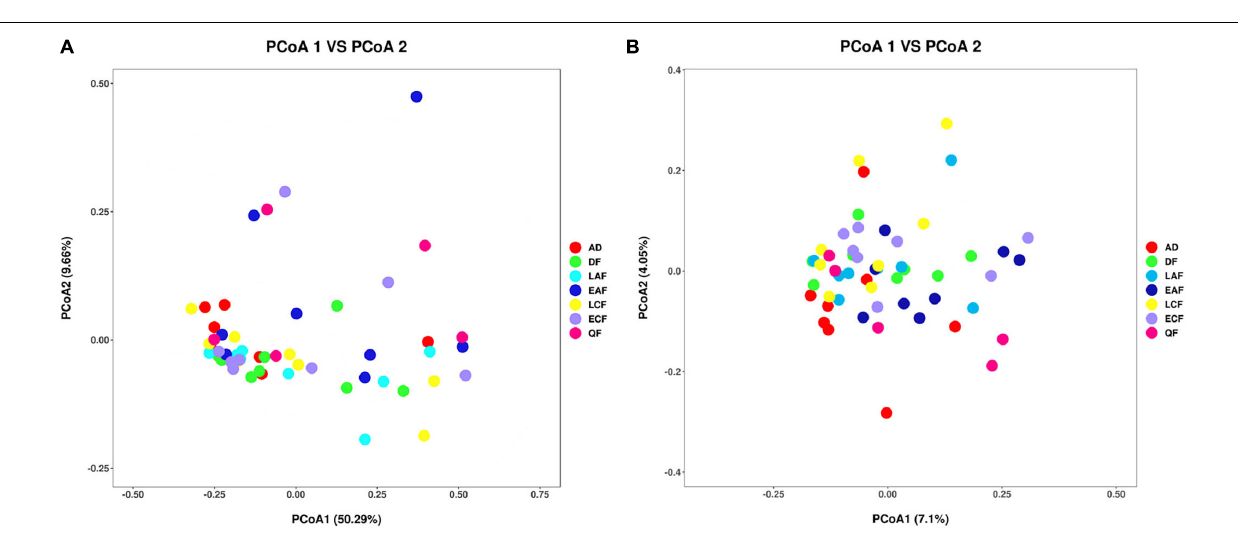
FIGURE 3 | Differential gut microbiota communities across all samples. (A) Principal coordinate analysis plot of weighted UniFrac distances for the F. tinnunculus species sampled from seven developmental stages. Each point represents the gut microbiota community of an individual F. tinnunculus . (B) Principal coordinate analysis plot of unweighted UniFrac distances for the F. tinnunculus species sampled from seven developmental